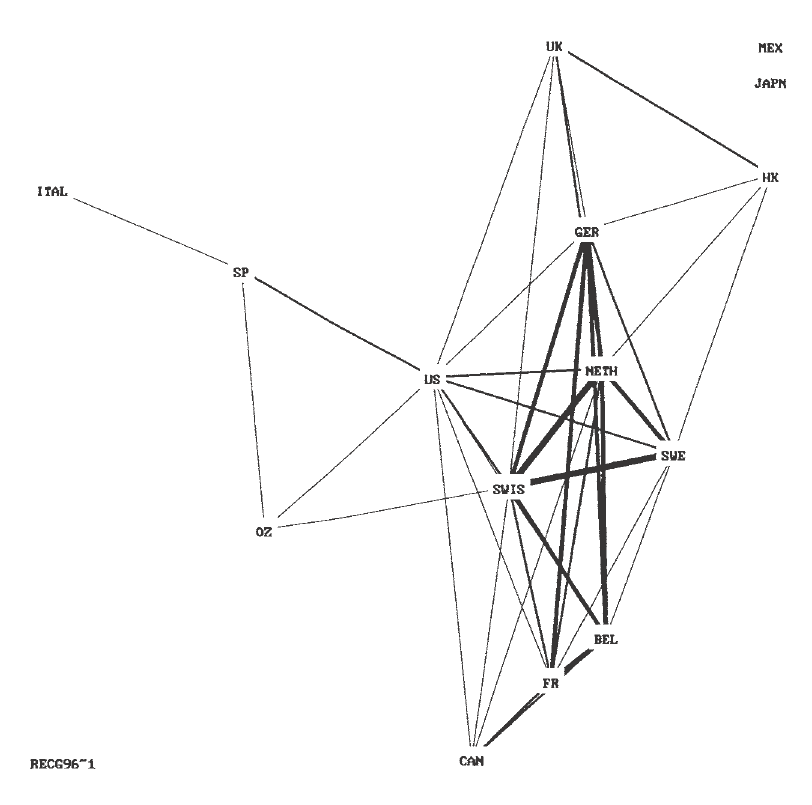
Figure 6 – Mean Inter-National Distances Among 271 Corporations, Based on Corporate Interlocks